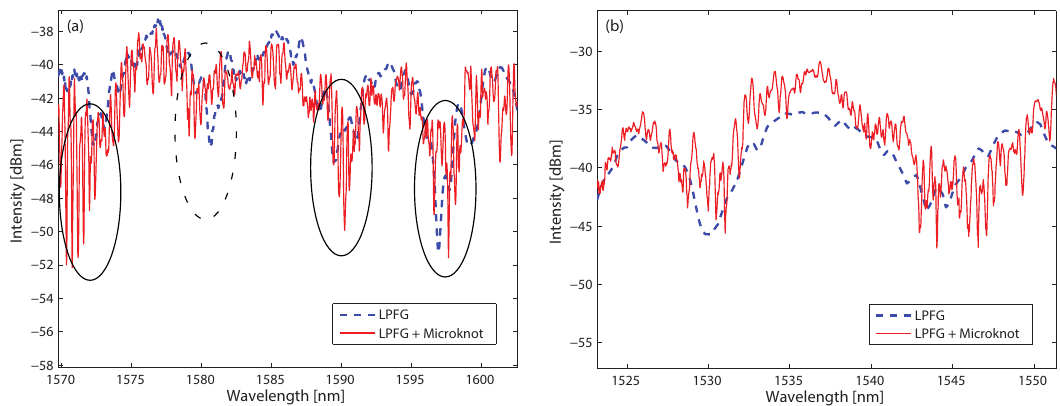
Figure 4. Transmission spectra of LPFGs before knotting the micro-knot denoted by the dashed blue curve and with the micro-knot denoted by the solid red curve. ( a ) LPFG of 5 mm long and a periodicity of 350 µ m, micro-knot diameter of 1.3 mm; ( b ) LPFG of 6.5 mm long and a periodicity of 180 µ m, micro-knot diameter of 950 µ m.